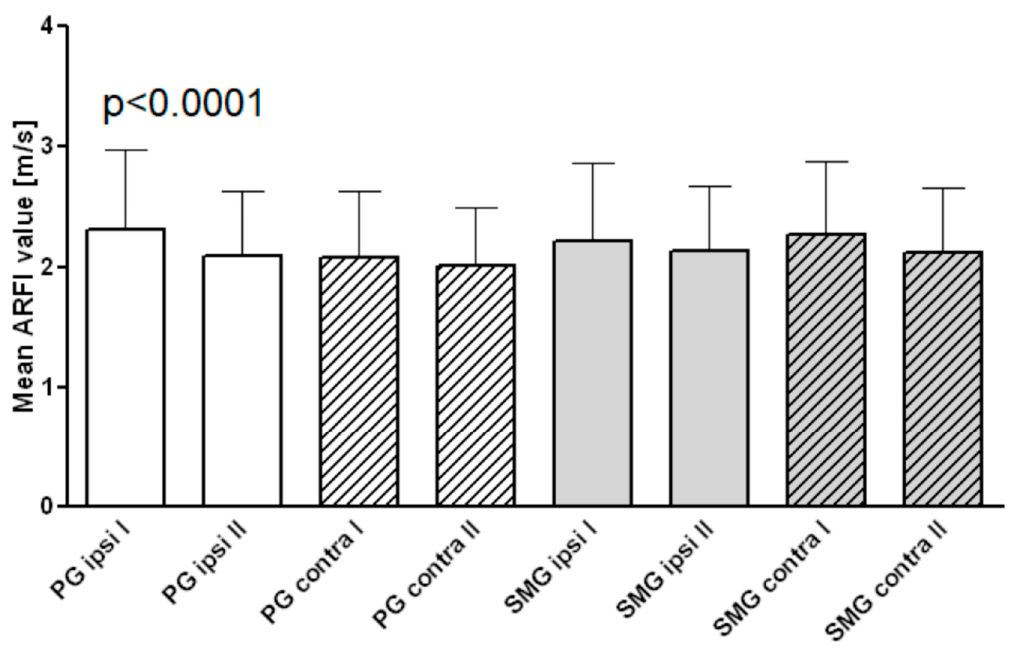
Figure 5. Point shear wave elastography (pSWE) imaging values of salivary gland tissue after tumor therapy before (I) and after (II) 2 months of topical liposomal